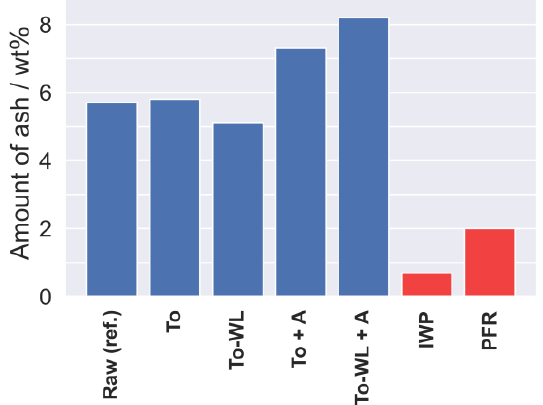
Figure 3. Amount of ash in dependence of different pre-treatment methods. The red bars denote the benchmark (IWP) as well as the alternative woody waste biomass (PFR). The ash contents are presented on a dry solid basis.